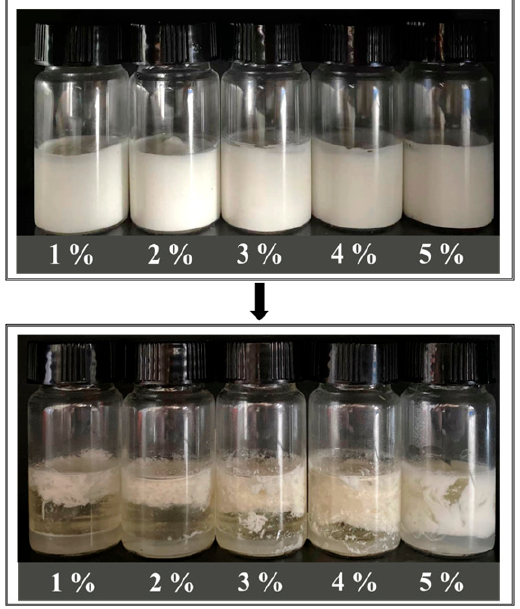
Figure 9. Appearance of HIPE stabilized by 1–5 wt% MPPI before and after one freeze–thaw cycle.